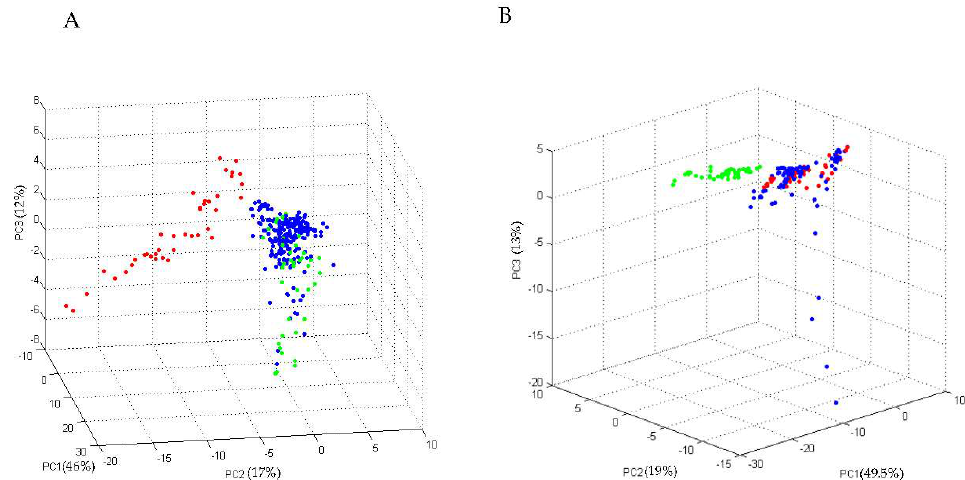
Figure 2. Three-dimensional plot of the spectra of the “training set” strains obtained by Principal Component Analysis (PCA) (colR-Ec strains in red and colS-Ec strains in green) in comparison to: ( A ) colS-Ec “test set” strains (blue) and ( B ) colR-Ec “test set” strains (blue) (dots of the same colour represent replicates of strains of the same class). For each principal component (PC), the percentage of the “explained variance” is reported in round bracket.